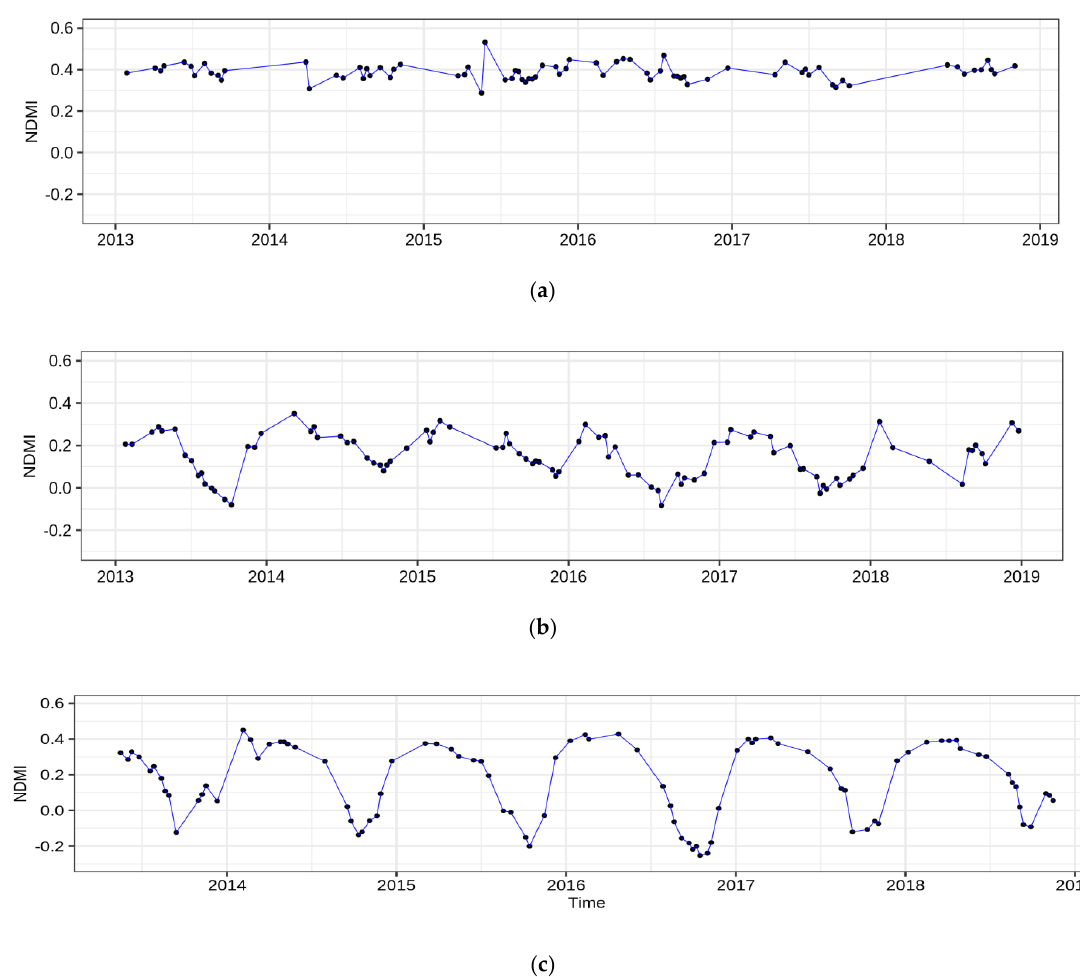
Figure 3. An example of Landsat pixel-time series for normalised di ff erence moisture index (NDMI) of a ( a ) humid (Peruvian site), ( b ) dry (Bolivian site) tropical forest site and ( c ) miombo woodland (Mozambican site). The time series are for undisturbed pixels.